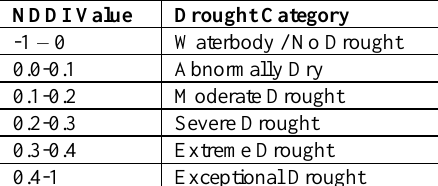
Table 1. NDDI based Drought Classification